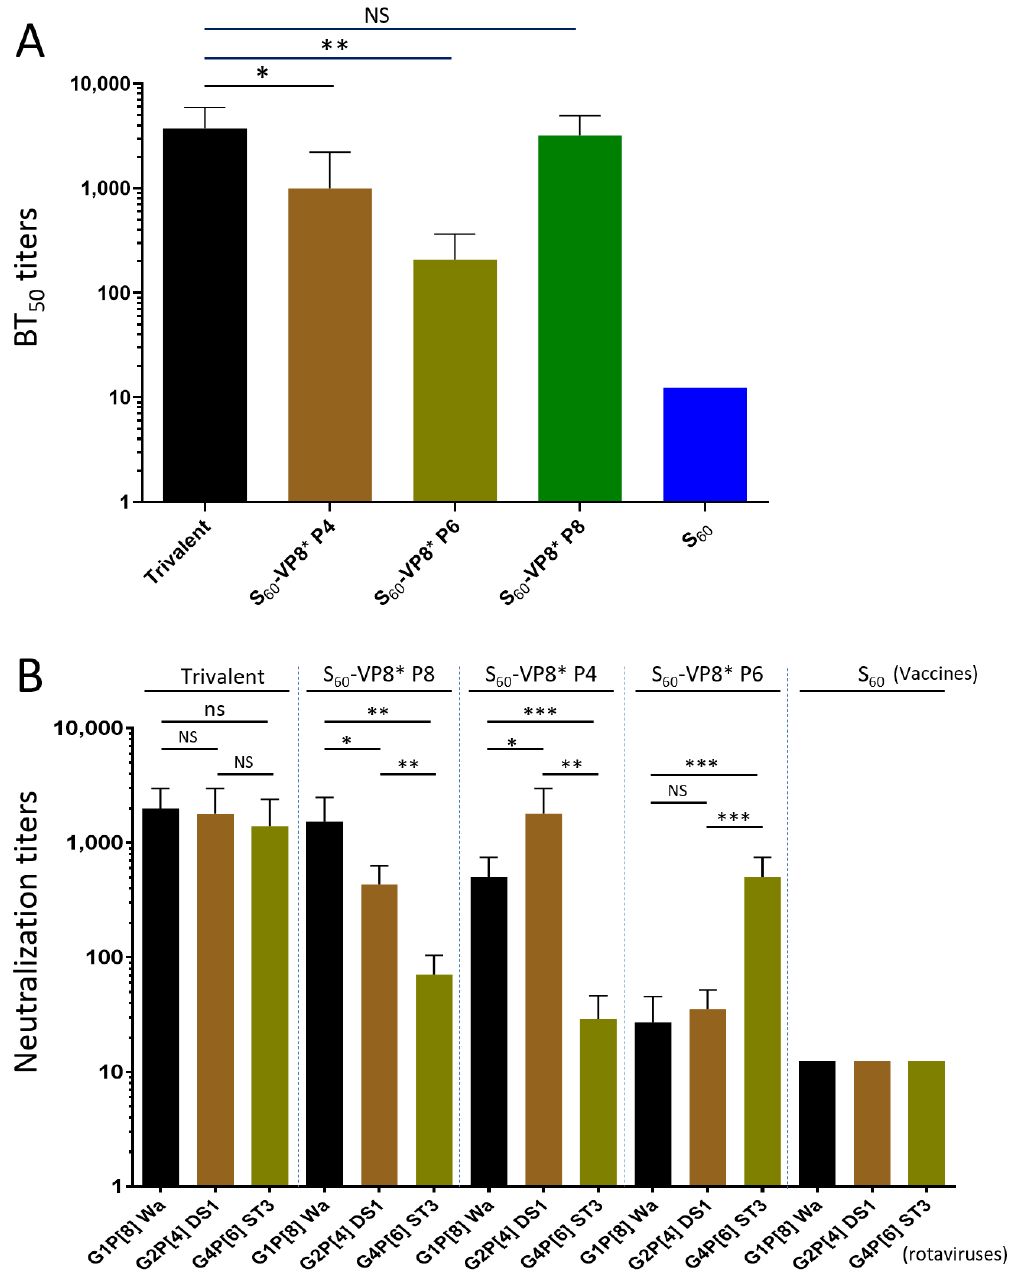
Figure 6. Blocking ( A ) and neutralization ( B ) titers of the mouse sera after immunization with the trivalent PVNP vaccine and controls against predominant rotavirus P types. ( A ) 50% blocking titers (BT 50 , Y -axis) of the mouse sera after immunization with the trivalent PVNP vaccine (trivalent) and the three single-valent PVNPs (X-axis) against attachment of the P 24 nanoparticle displaying P[8] VP8* to glycan receptors in a Le b positive saliva sample. ( B ) 50% neutralization titers (Y-axis) of mouse sera after administration with the trivalent vaccine (trivalent) against replication of a P[8] (Wa strain, G1P8, black columns), a P[4] (DS-1 strain, G2P4, brown columns), and a P[6] (ST-3, G4P6, green columns) rotavirus, respectively, in cell culture, using the mouse sera after immunization with the three single-valent PVNPs and the S 60 nanoparticle without VP8* antigens (S 60 ) as controls (indicated on the top). Statistical differences between data groups with corresponding p -values are calculated and shown in the Supplementary Materials . “ns” , non-significant for p -values >0.05; “*”, significant for p -values <0.05; “**”, highly significant for p -values <0.01; “***”, extremely significant for p -values < 0.001.